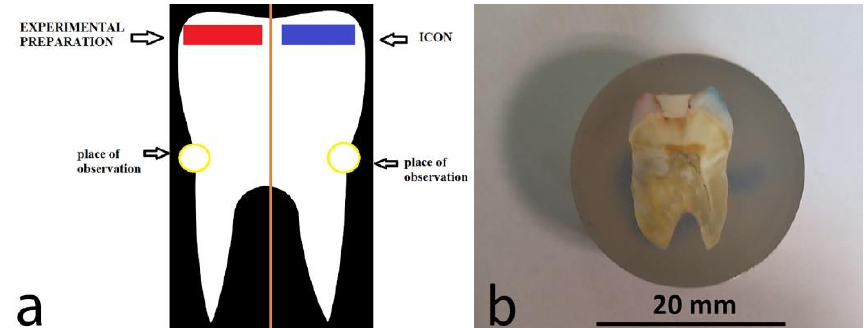
Figure 2. ( a ) Graphically marked tooth zones and areas for microscopic observation; ( b ) a photo of a resin-embedded tooth imaged with a stereoscopic microscope. The red side shows the zone with the applied experimental preparation, and the blue side shows the tooth with the applied commercial preparation Icon.